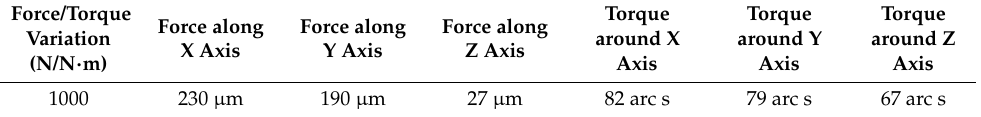
Table 2. Theoretical calculation value of reference point deformation of the force-measuring